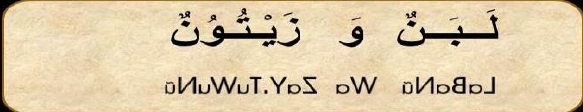
Figure 8. Preferences of identification